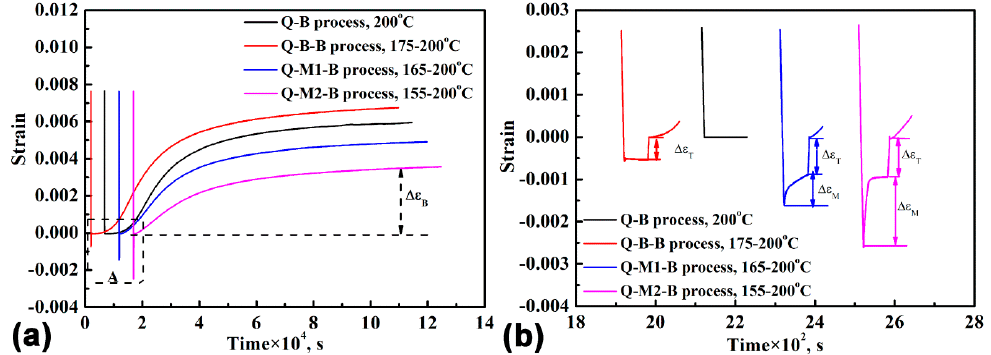
Figure 3. ( a ) Kinetic curves for phase transformation for the specimens with different processes, ( b ) the enlarged view of region A. Note: ∆ ε T , ∆ ε B and ∆ ε M represent the strain results from temperature, bainite and martensite, respectively.